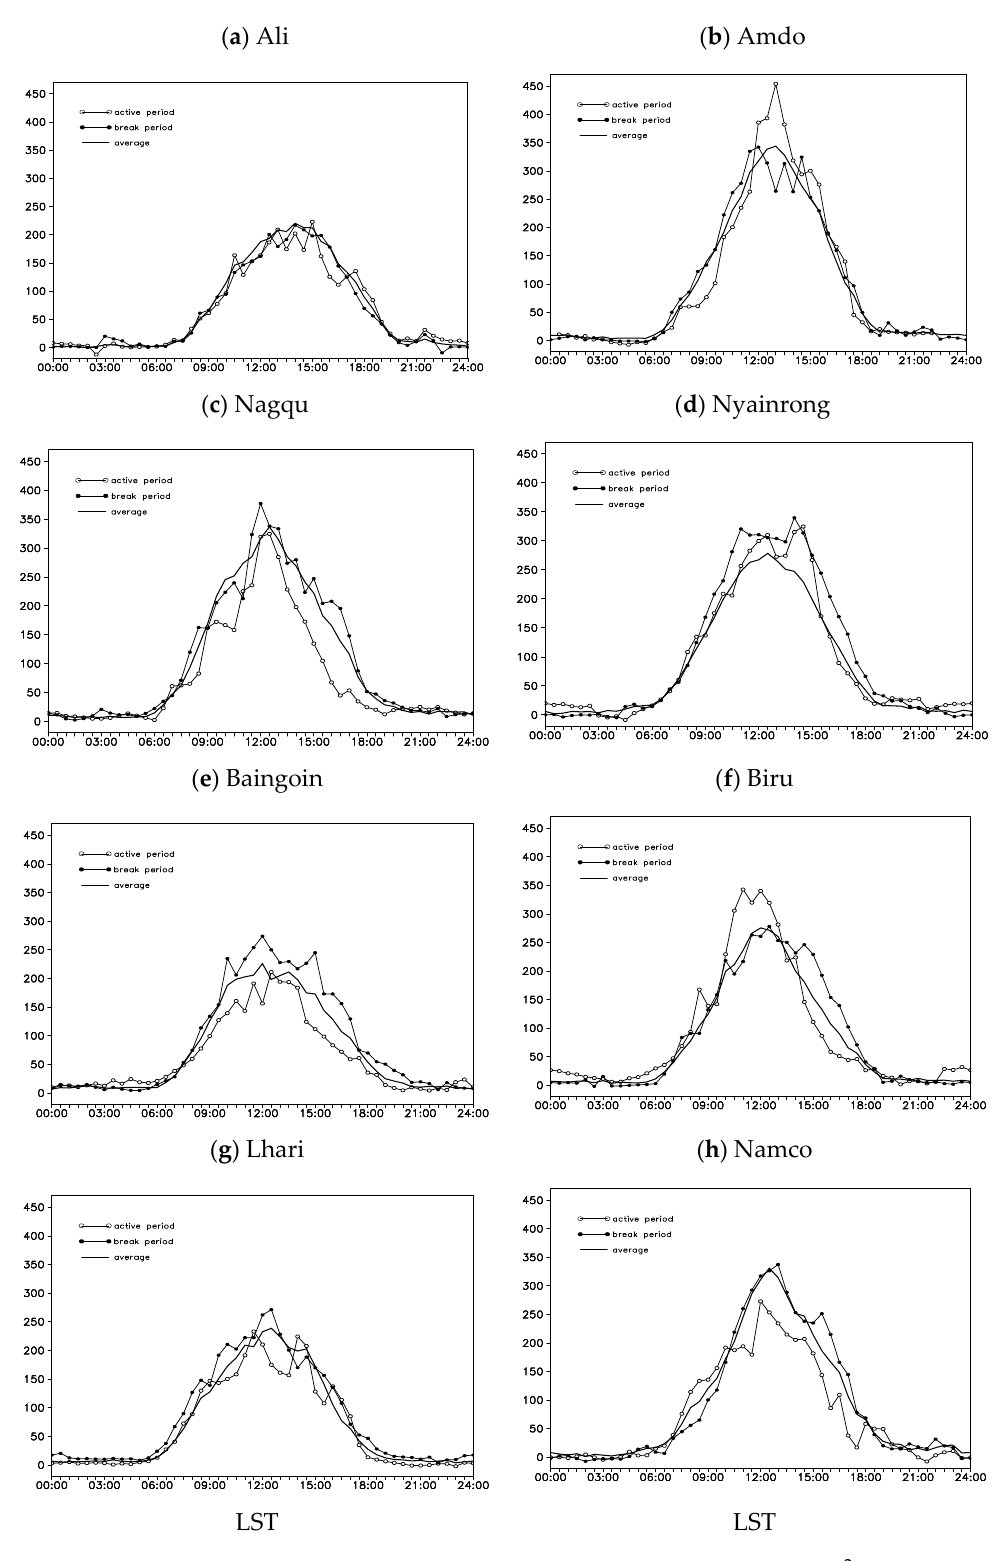
Figure 9. Same as Figure 7, but for total heat flux (TH) (units:Wm − 2 ). Table 4. Total heat flux (TH) (Wm − 2 ) over the 8 plateau stations, averaged for the observations and SASM active and break periods. The bracketed values denote the TH increasing (decreasing) percentage of the daily averaged value, in which the positive (negative) values mean increasing (decreasing).